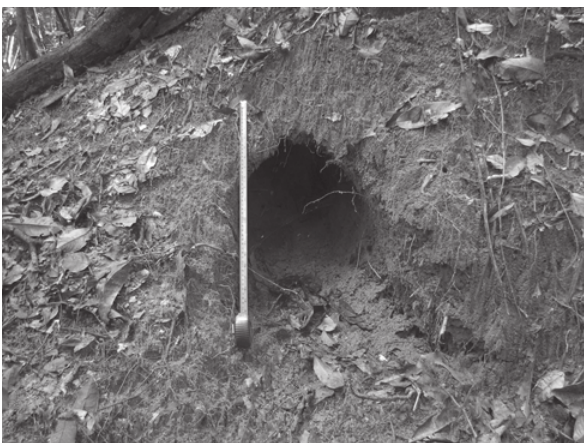
Figure 1. A typical burrow of P. maximus found in Parque Estadual do Rio Doce. The measuring tape is extended to 0.5